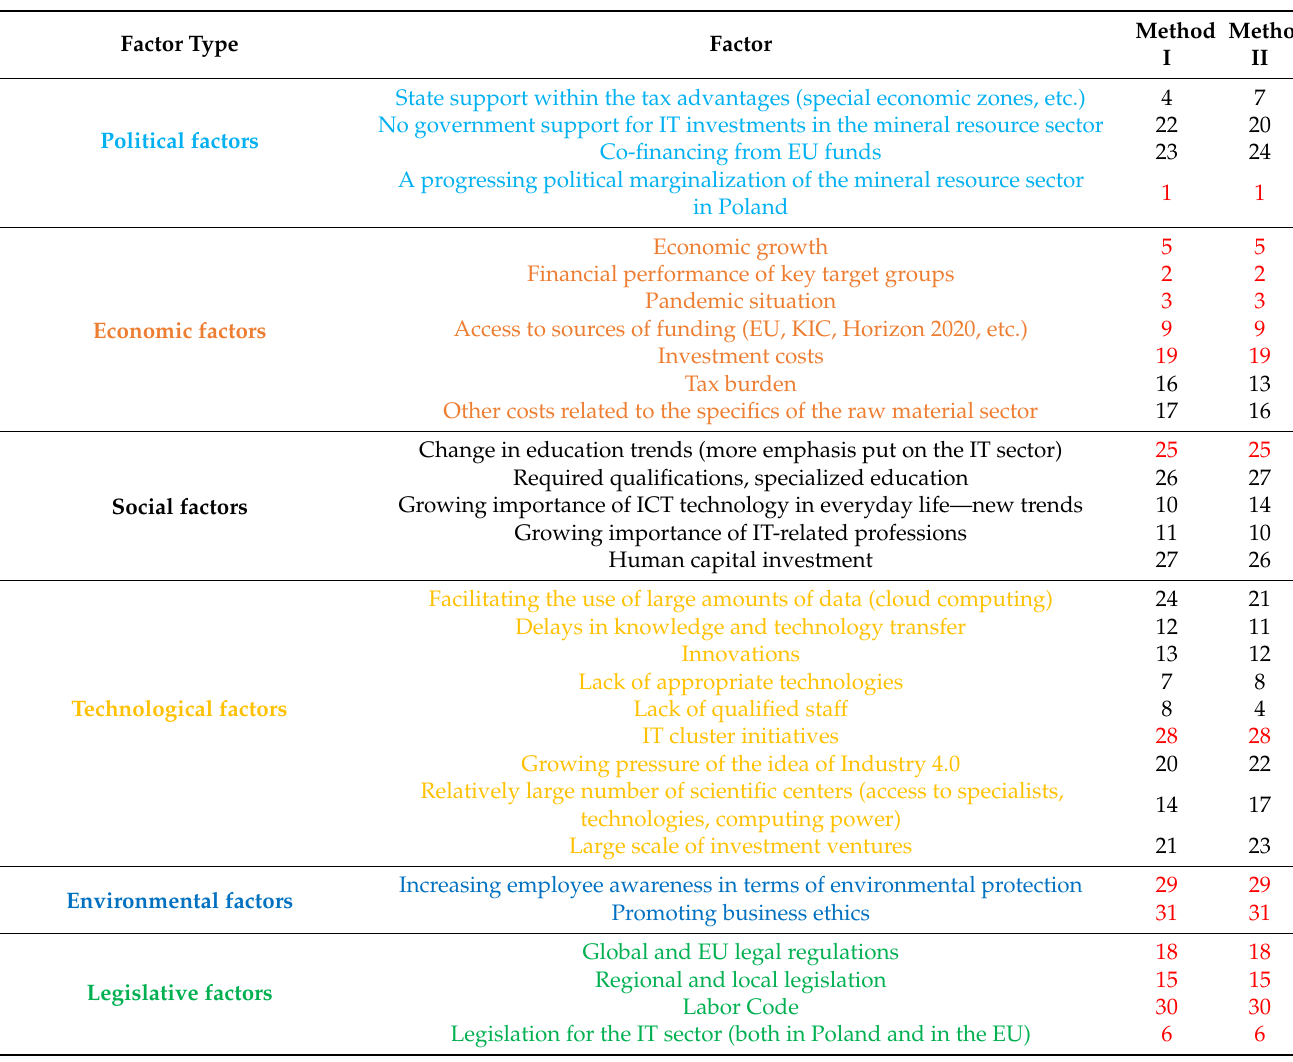
Table 3. Ranking of the significance of factors in six groups according to the two